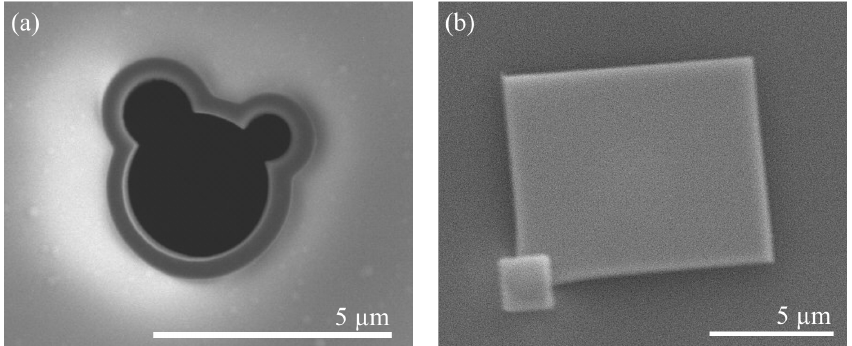
Figure 2. ( a ) Scanning electron microscopy (SEM) image of the sample aperture; ( b ) FeGe thin plate fixed on the opposite side of Si 3 N 4 membrane by a tungsten